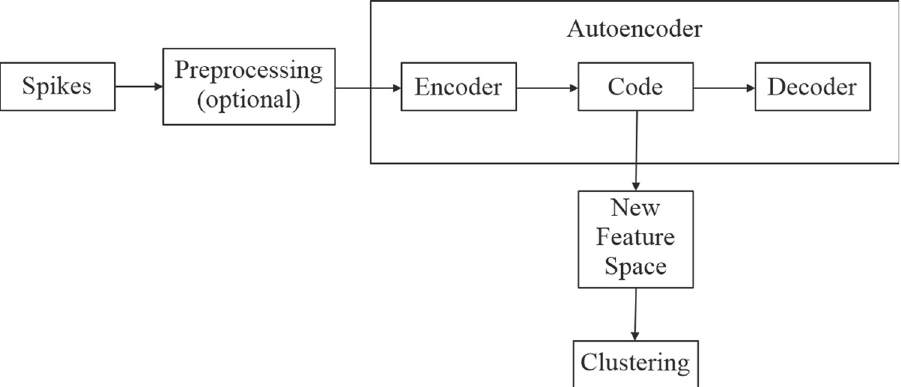
Fig 2. The general model of autoencoder for feature extraction. The input spikes are used to train the autoencoder. Once trained, the values obtained at the code layer can be extracted as a new feature space that is used in the clustering of the spikes. The preprocessing of the input data before training is